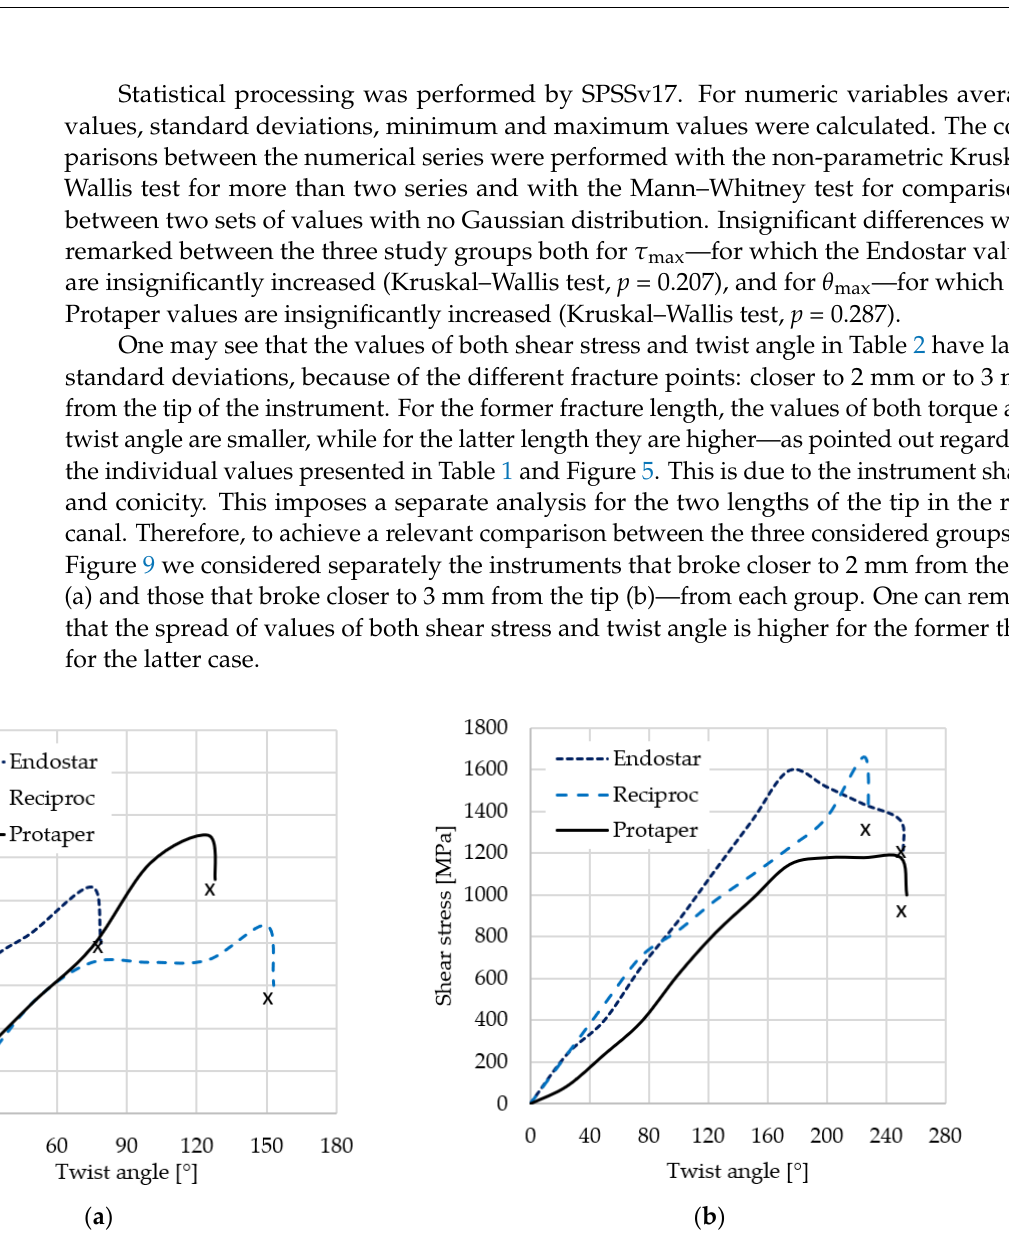
Figure 9. Shear stresses τ max versus twist angles θ of the Endostar, Reciproc and Protaper instruments: graphs obtained for samples that experience ( a ) low and ( b ) high torque and twist angle at failure.